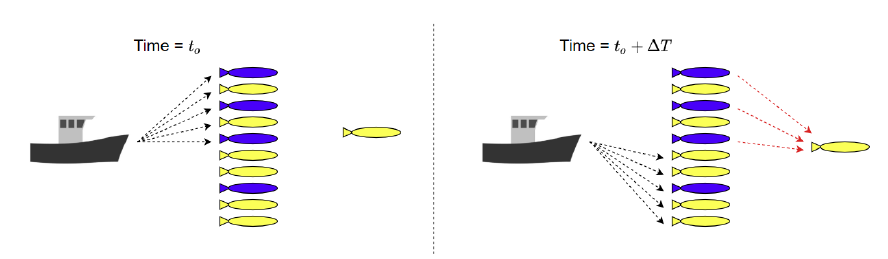
Figure 13. The proposed fuzzy-based localisation framework harnesses round-robin scheduling for USBL navigation aid assuming that all AUVs requested USBL navigation aid. The USBL can only navigatioanlly aid five AUVs in a single TDMA frame of ∆ T utilising low-frequency ACOMMS (in black arrows). NBs (in blue) broadcast localisation aid to their neighbouring AUV utilising high-frequency ACOMMS (in red arrows).